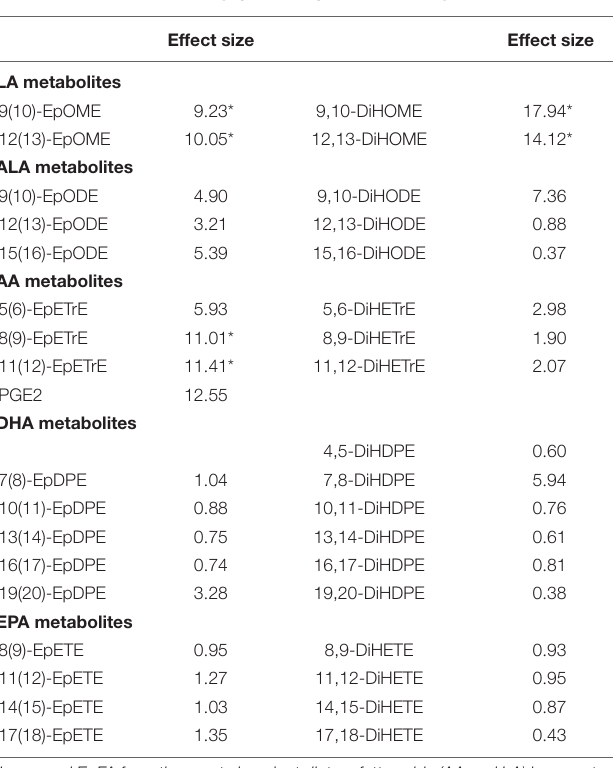
TABLE 2 | Effect size (mean fold-difference between COVID-positive and control) of EpFA, diols, and oxylipins with greater than 8-fold difference (* p < 0.0001). Effect size of oxylipins compared to healthy